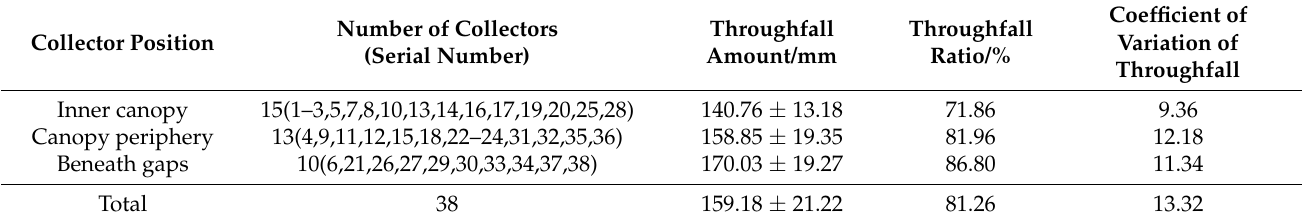
Table 3. Distribution of throughfall under the canopy of L. gmelinii